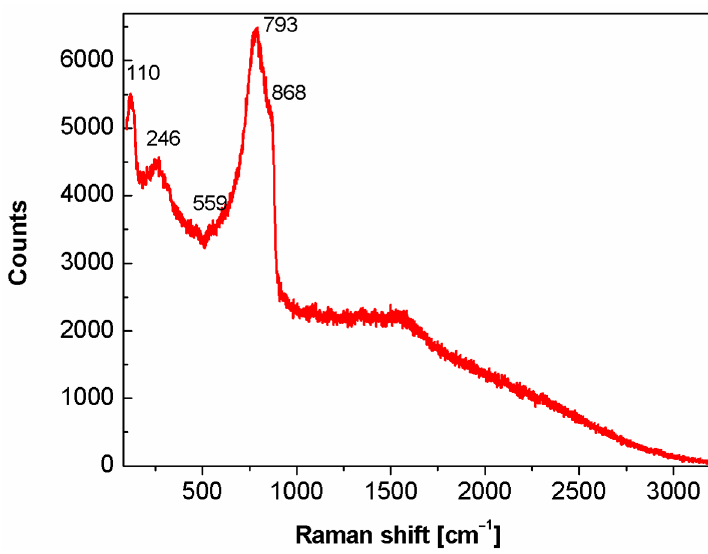
Figure 7. Raman spectrum for the columbite–tantalite crystals from